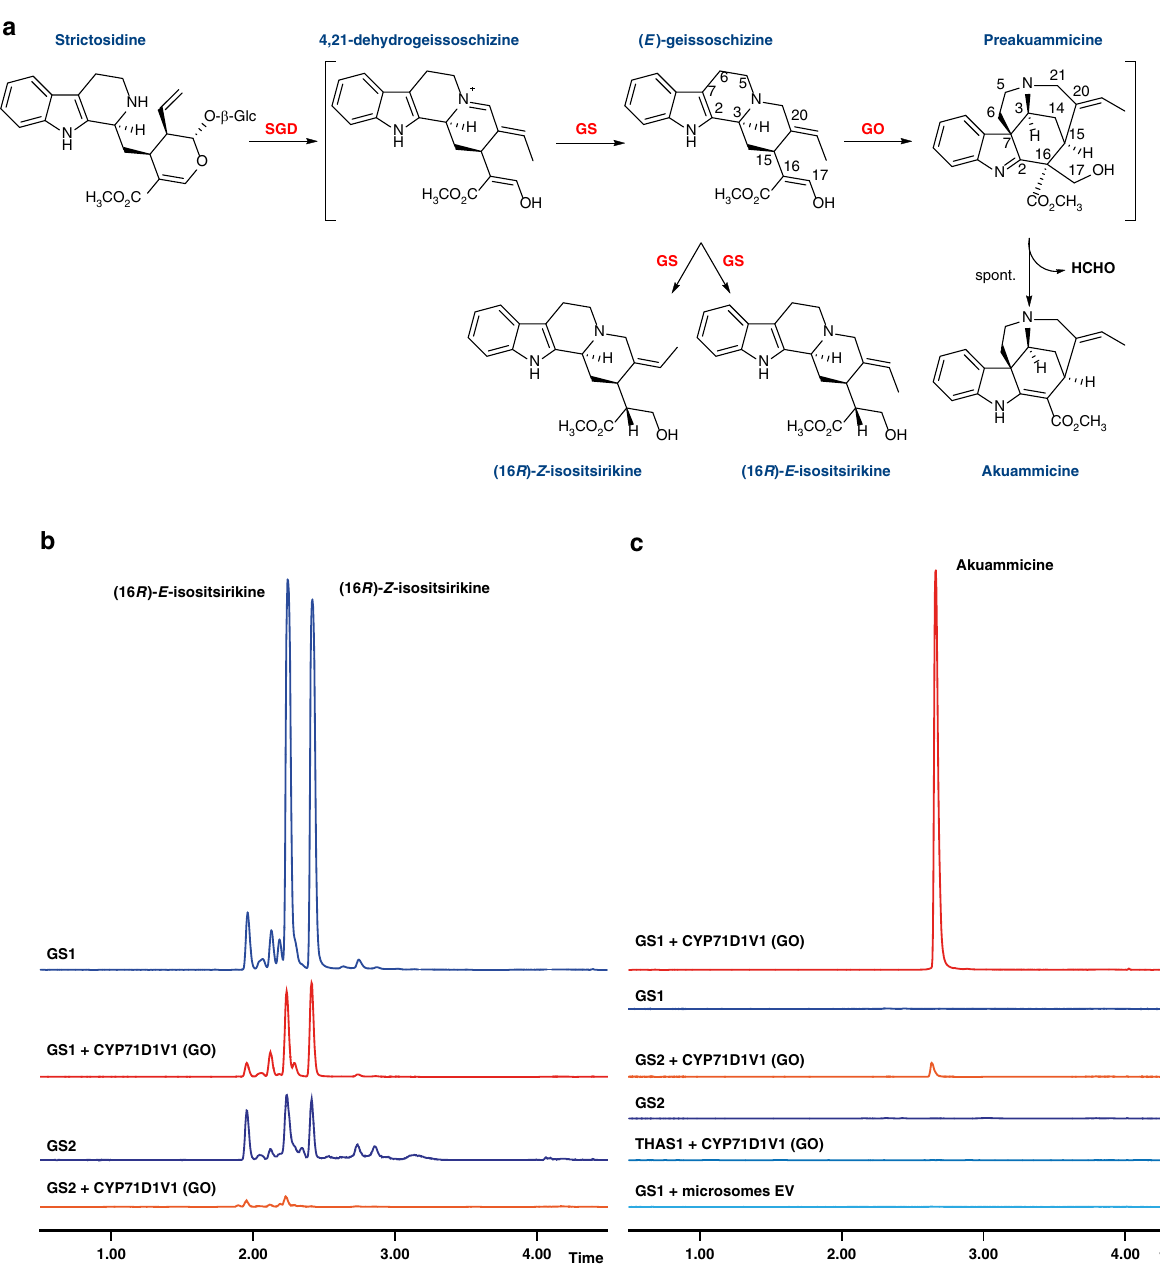
Fig. 2 Enzymatic activity of GS1 and GS2 and GO (CYP71D1V1). a Reaction of strictosidine with SGD, GS and GO. b Multiple reaction monitoring (MRM) on a LCMS showing compounds at m/z 355 in enzymatic assays of GS1/2 and GO. Isolation and NMR characterization of the two major compounds indicated that they are (16 R )- E -isositsirikine and (16 R )- Z -isositsirikine (Supplementary Figs 5 – 16). c MRM ( m/z 323) of an akuammicine standard compared with enzymatic products of GS1/2 and GO. THAS1 is a medium chain alcohol dehydrogenase involved in the heteroyohimbine monoterpene indole alkaloid pathway (Supplementary Fig. 1). EV empty